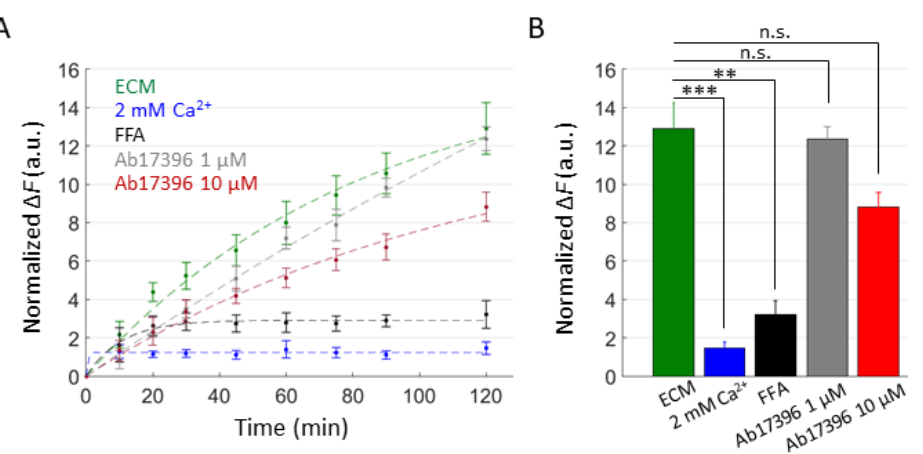
Figure 7. DAPI uptake assay in HaCaT-Cx46-GCaMP6s cells. ( A ) Time course of DAPI uptake assay performed with a plate reader in dox-induced HaCaT-Cx46-GCaMP6s stable pools. Cells were exposed to DAPI (5 µM) dissolved in: ECM (green), ECM supplemented with 2 mM Ca 2+ (blue), ECM plus FFA (100 µM, black), ECM plus Ab17396 1 µM (gray) and ECM plus Ab17396 10 µM (red). In each condition, DAPI uptake was measured as the average fluorescence signal variation Δ 𝐹 = 𝐹(𝑡) − 𝐹 0 of 3 ≤ n ≤ 6 cultures at different time points, from 5 min after the beginning of dye incubation ( t = 0) up to 2 h later. The data are quoted as the mean values ± s.e.m. ( B ) The mean Δ 𝐹 values obtained for each condition shown in ( A ) at the end of the observation time window (2 h); statistical significance was calculated using the two-tailed t -test; **, P < 0.01; ***, P < 0.001; and n.s., not significant.